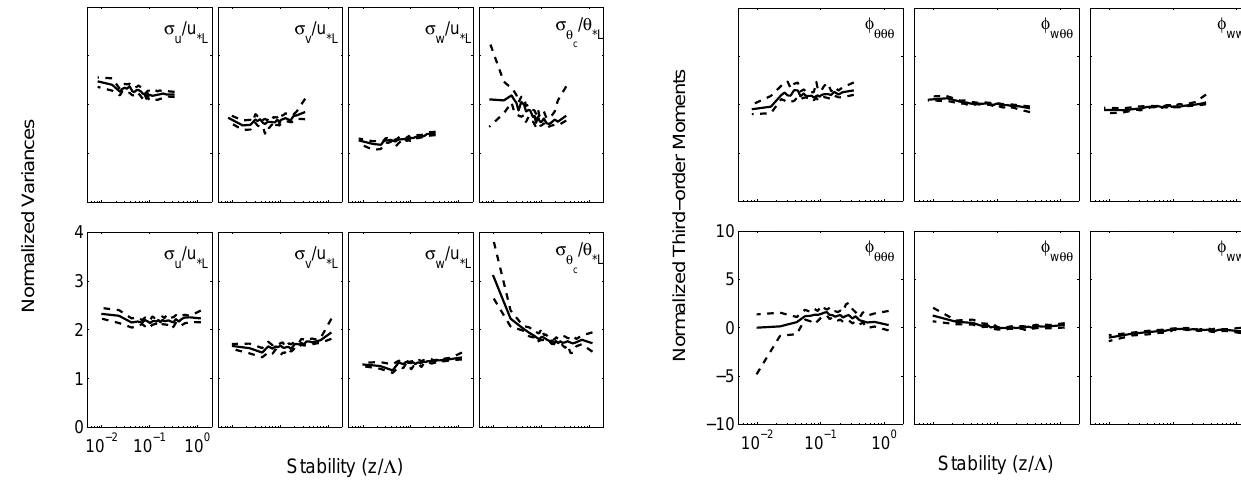
Fig. 5. The panels from left to right represent third-order mo- ments φ θθθ , φ wθθ , and φ wwθ , respectively; where φ θθθ = 2 i h w 0 θ 0 h w 0 2 θ 0 i c c φ wθθ = . The upper and lower panels , and φ wwθ = u ∗ L θ 2 ∗ L u 2 ∗ L θ ∗ L correspond to the 3.1m and the 7m sonic anemometers, respec- tively. All the panels have identical abscissa and ordinate limits.